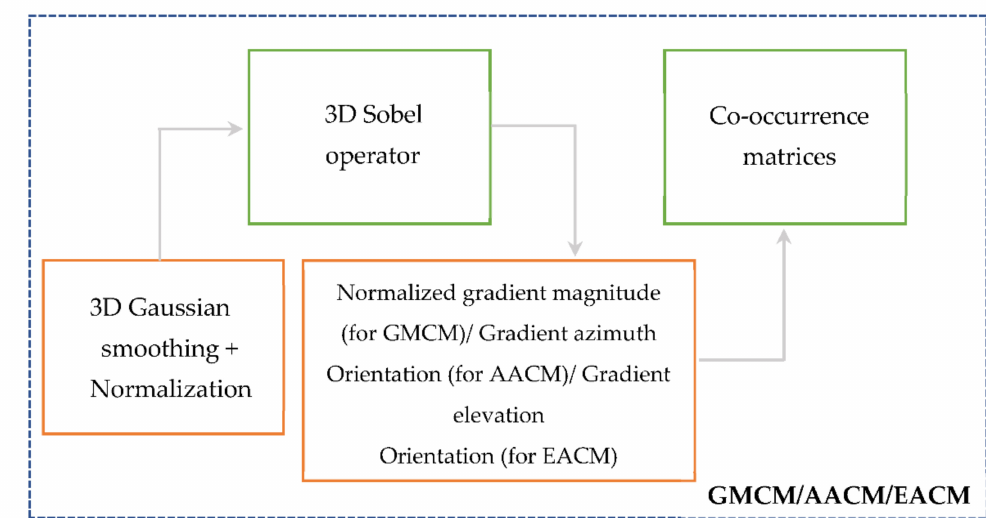
Figure 8. The calculation of the GMCM, AACM and EACM matrices (© [2020] IEEE. Reprinted [adapted], with permission, from